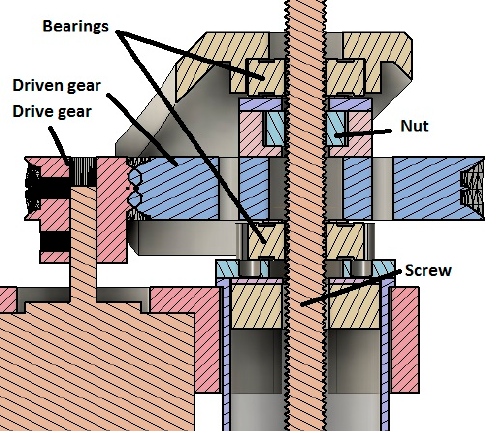
Figure 5. Section view of a virtual model of the paste extruder.